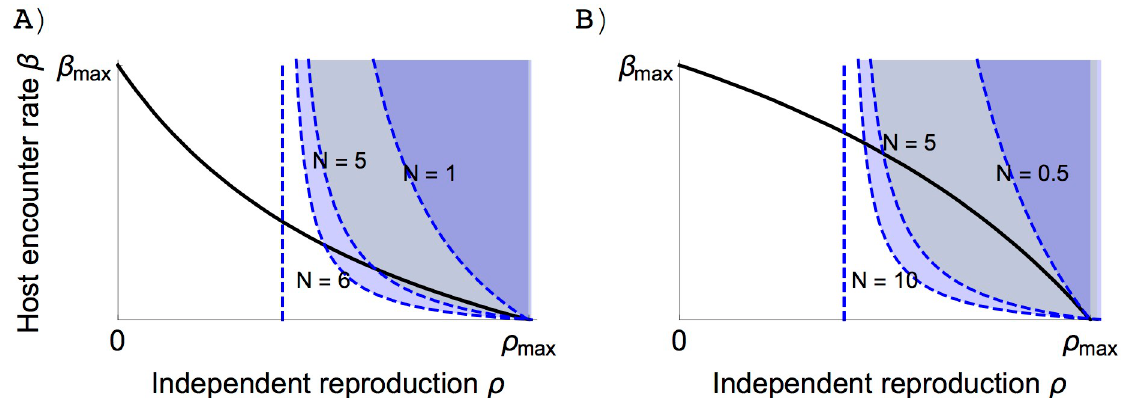
Fig 7. Different invasion boundaries (dashed lines) of the residents with zero host encounter rate in the environment of different total number of hosts N . The lower the density of the total host population, the more negative the slope of the invasion boundary (dashed lines) compared with the slope of the trade-off curve (black line). A) Concave trade-off α = 3.1, δ = 1.3. B) convex trade-off α = 0.7, δ = 1.3. The blue lines are the invasion boundaries that respectively corresponds to different values of density of total host population N . Other parameter values b = 1, c = 2, σ = 0, ν = 3, μ 0 = 3, β max = 5, ω = 6.5.